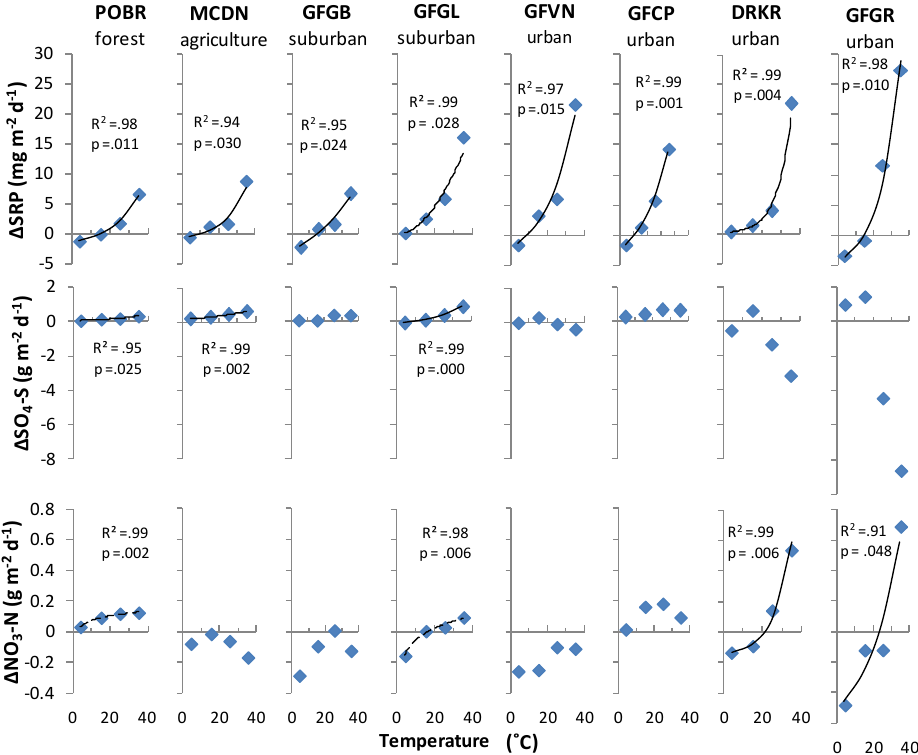
Fig. 6. Plots of SRP, sulfate and nitrate fluxes versus incubation temperature. Best fit regressions were exponential for SRP at all sites, and nitrate and sulfate at selected sites. Best fit regressions at POBR and GFGL were logarithmic (in dash). Regression fits were not included for sites without significant trends ( p > 0 .